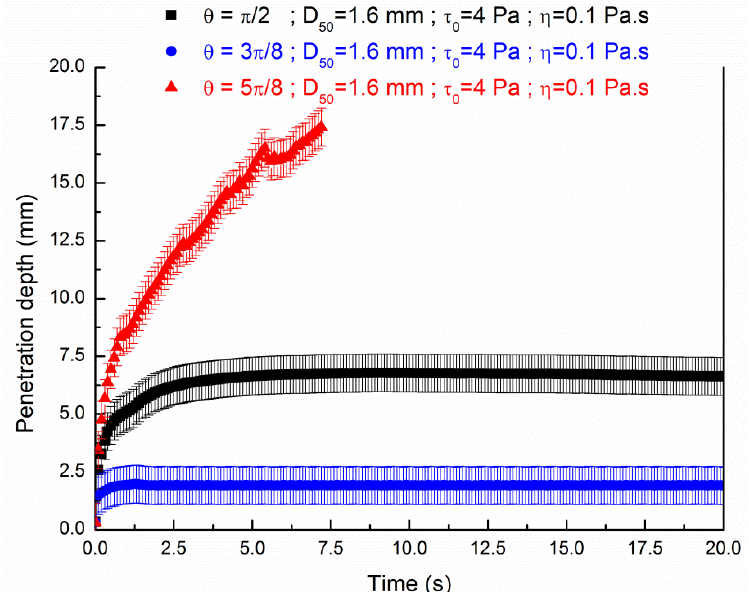
Figure 8. Influence of the contact angle at the interface for the penetration of a yield stress fluid (𝜏 0,𝑒𝑥𝑝 = 4 Pa; 𝜂 𝑒𝑥𝑝 = 0.1 Pa · s) in a sand bed particles of 20 mm height and d agg = 1.6 mm.